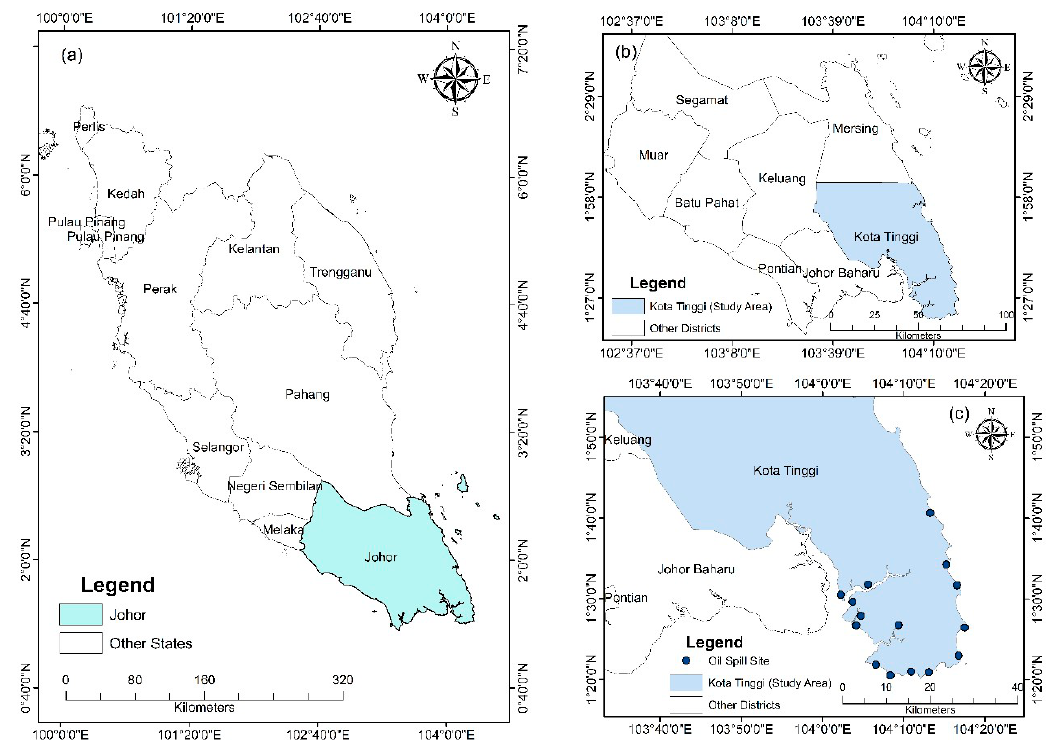
Figure 1. ( a ) Map of Peninsular Malaysia showing Johor; ( b ) Johor showing Kota-Tinggi Study Area; ( c ) Location of Oil Spill Sites in the Study Area.